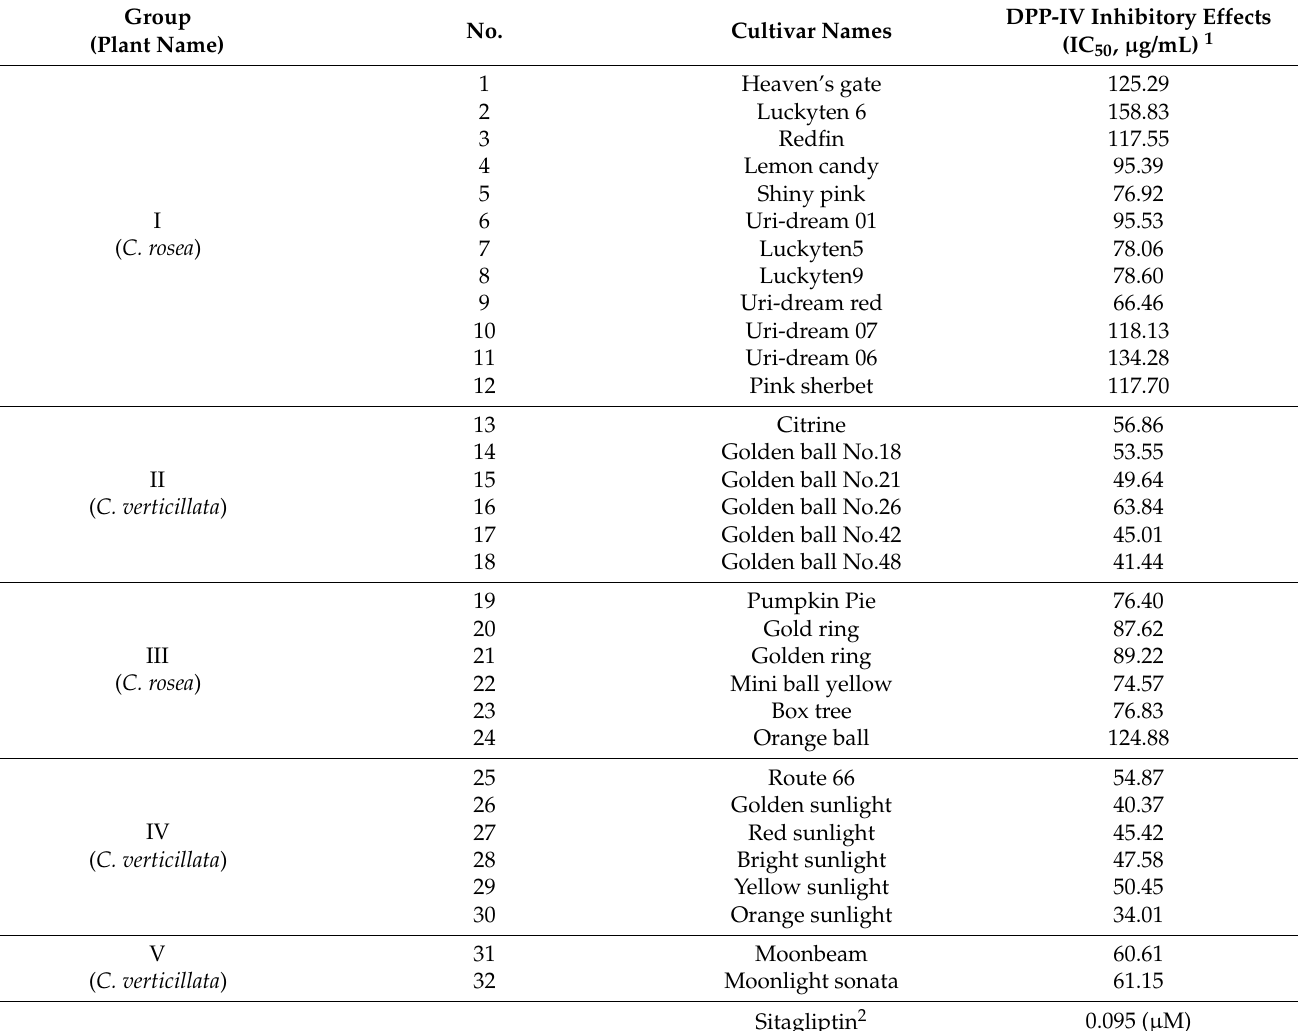
Table 3. Effects of the 70% ethanol extract of Coreopsis cultivars on dipeptidyl peptidase (DPP)-IV activity.